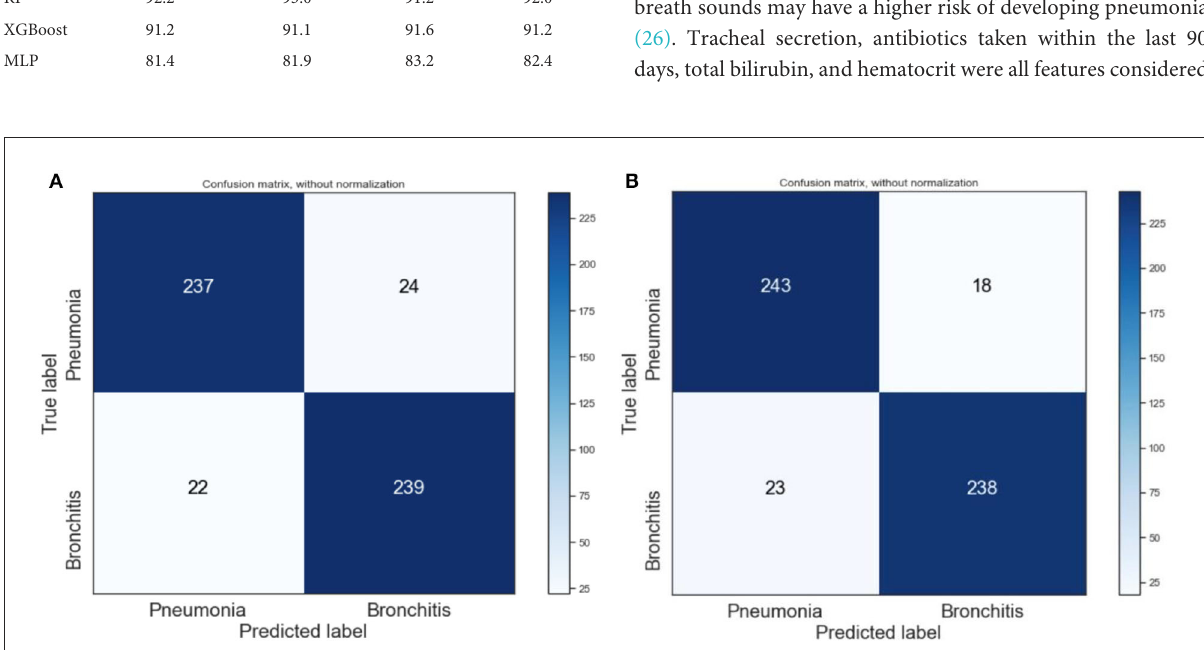
FIGURE7 Confusion matrix of XGBoost and RF on SMOTE data. (A) XGBoost. (B)